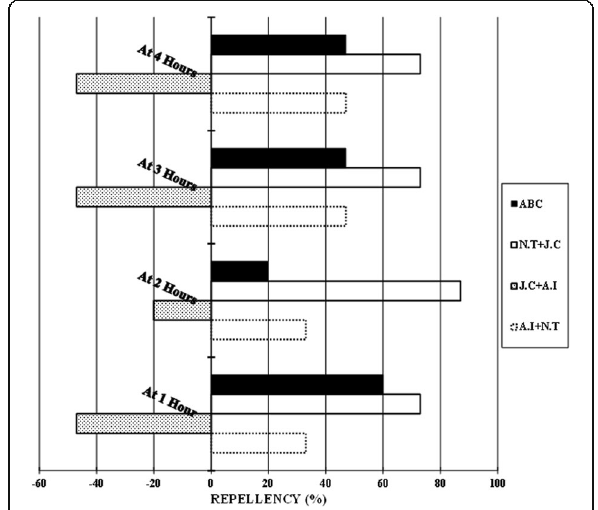
Fig. 5 Percentage mortality of Macrotermes subhyalinus repelled by plant extracts. Bars on the right side of the Y -axis shows positive repellency while bars on the left show negative repellency. A.I+N.T = Azadirachta indica plus Nicotiana tabacum. J .C+A.I = Jatropha curcas plus Azadirachta indica. N .T+J.C = Nicotiana tabacum plus Jatropha